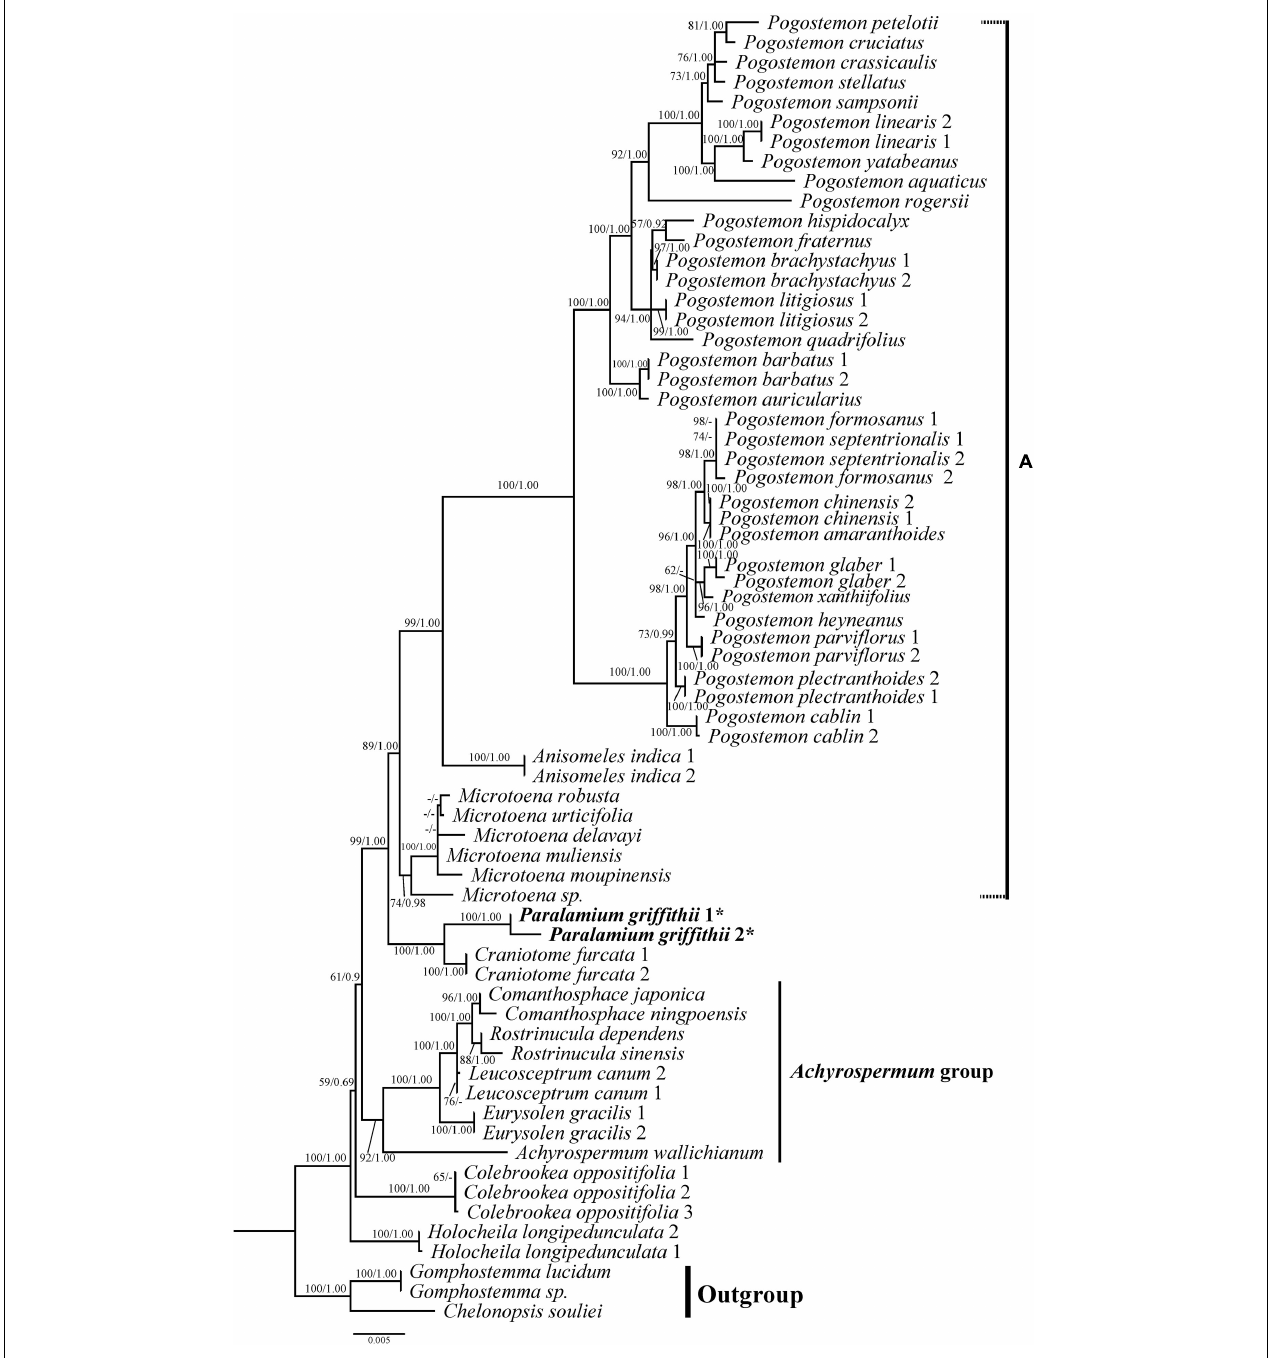
FIGURE 4 | Phylogenetic relationships of Pogostemoneae based on the dataset CP5. The support values (BS/PP) are indicated above branches. BS values < 50% and PP support < 90% indicated by -. The outgroup and other major groups are labeled at the right.